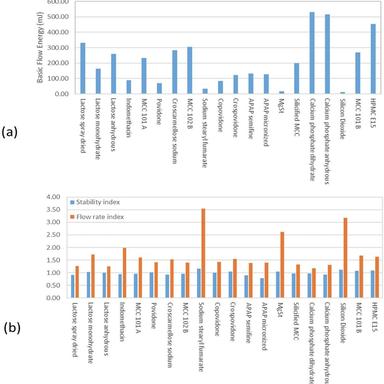
Material characterization results from dynamic flow test. (a) shows the flow energy required on the seventh downward blade pass during testing, and in (b), the specific energy is the energy consumed during the seventh upward traverse and the stability index shows the change of flow energy over time.